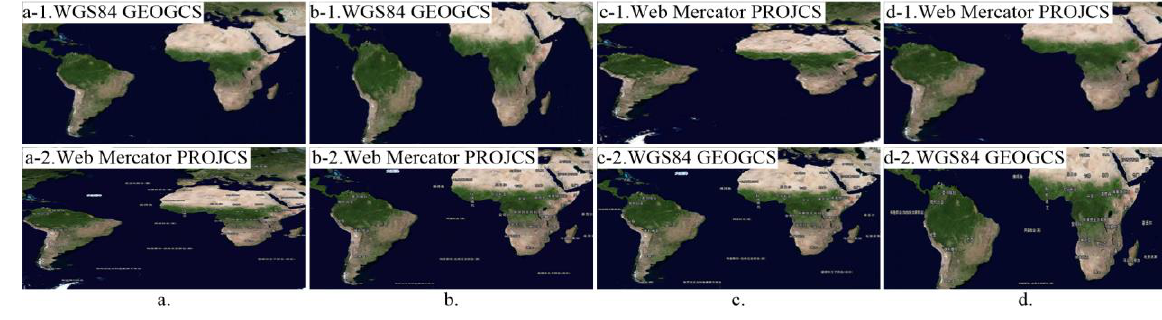
Figure 4. Diagram under the same data sources with different spatial references (with deformation)